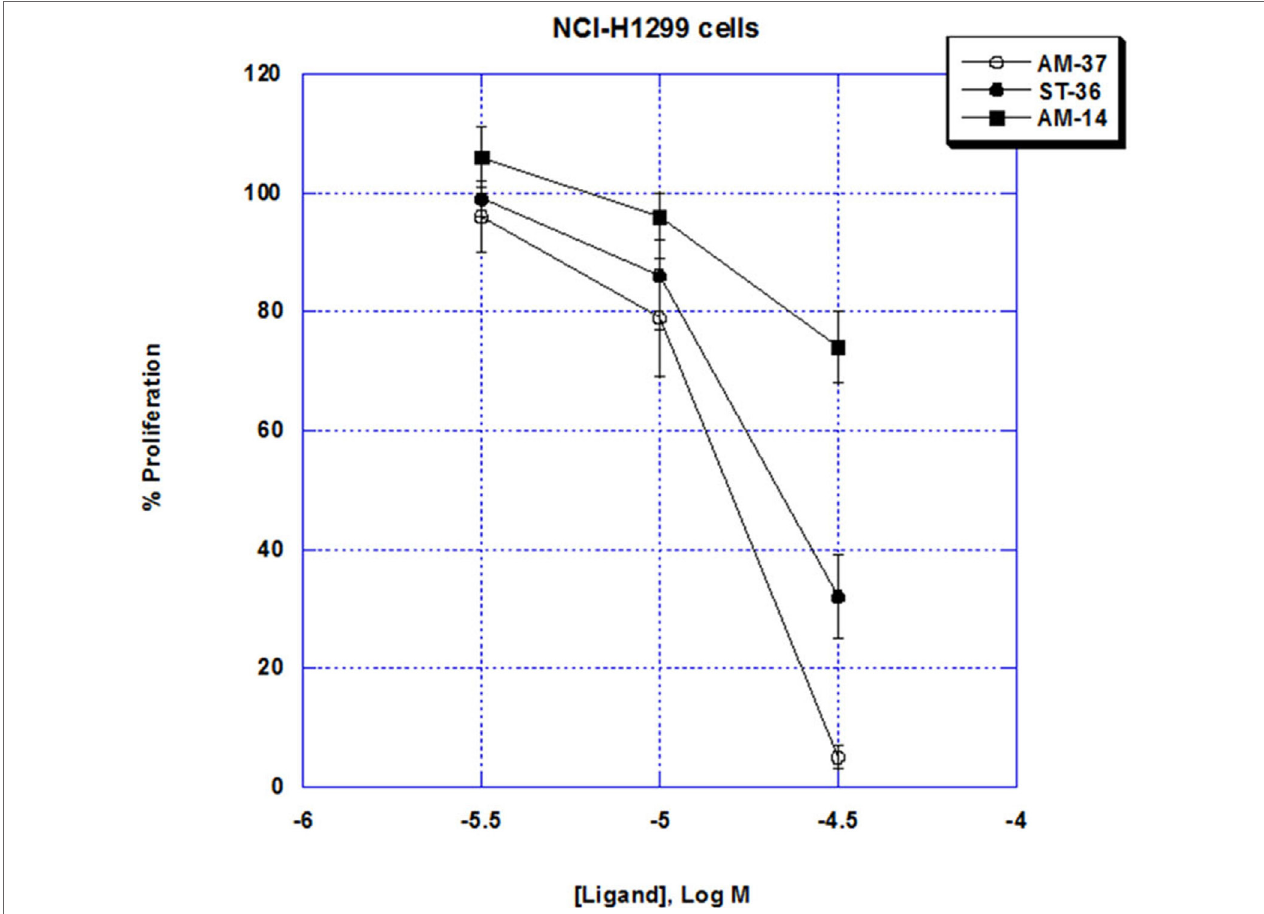
FigUre 4 | MTT assay. The ability of varying doses of AM-37 (o), ST-36 ( ⚫ ), and AM-14 ( ◾ ), to inhibit the proliferation of NCI-H1299 cells is shown. The mean value ± SD of eight determinations is indicated. This experiment is representative of two